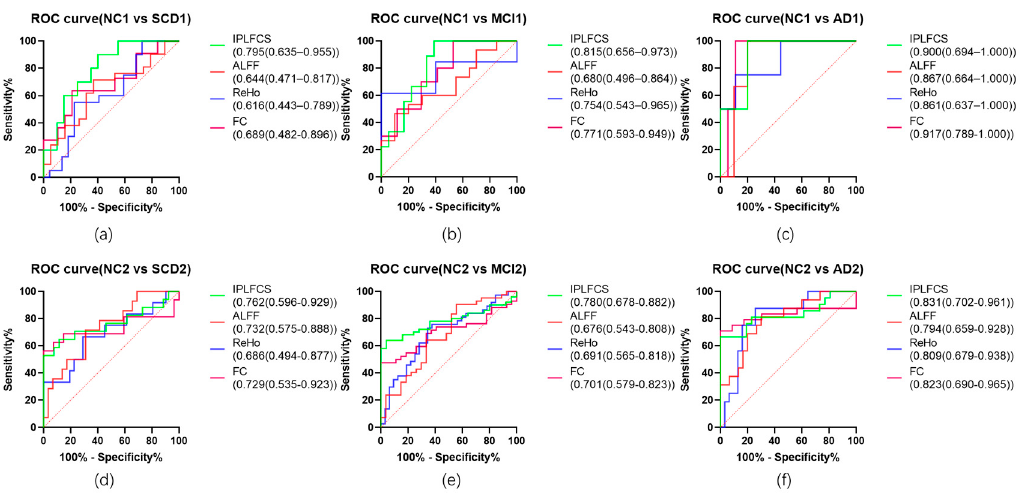
Figure 5. The results of ROC analysis among IPLFCS, ALFF, ReHo and FC. ( a ) The ROC results of NC1 vs. SCD1. ( b ) The ROC results of NC1 vs. MCI1. ( c ) The ROC results of NC1 vs. AD1. ( d ) The ROC results of NC2 vs. SCD2. ( e ) The ROC results of NC2 vs. MCI2. ( f ) The ROC results of NC2 vs. AD2.